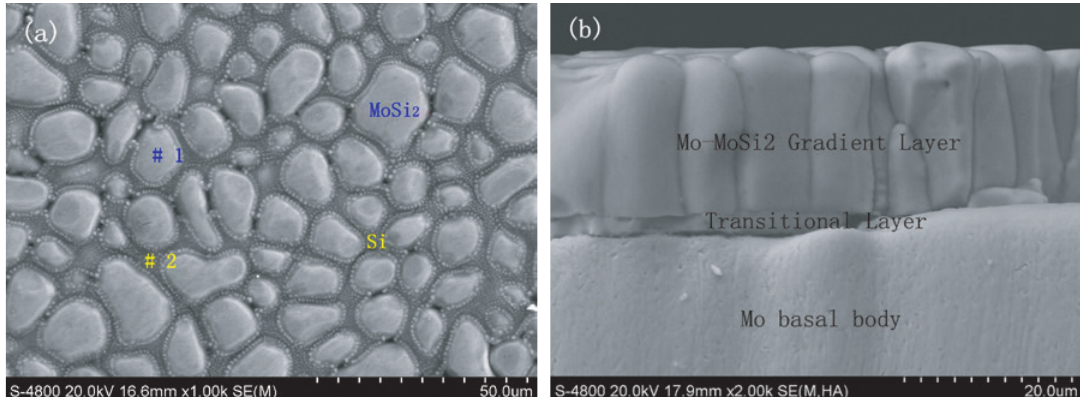
Fig. 3: SEM photos of coating surface (a) and cross-section